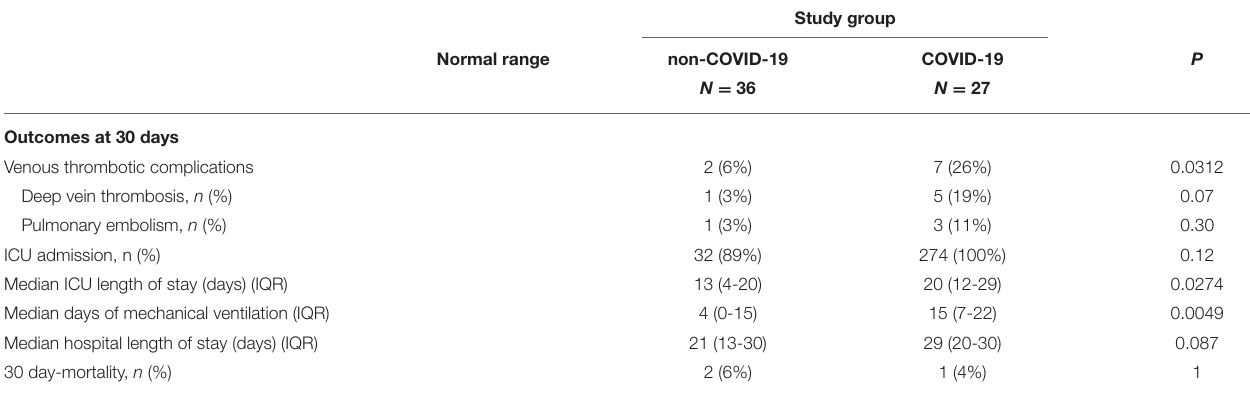
the 30 correlated original variables ( Supplementary Table 3 , Supplementary Figure 1 ). Two of the three factors in the final pattern were associated with outcomes. Factor 1 associated (1) baseline severity and extra-respiratory organ dysfunction (SOFA and PSI scores, lactate, creatinine and NT-ProBNP levels) and (2) “classical” markers of coagulation and endothelium activation (i.e. D-dimer, vWF-A2, sTM, sICAM1, TREM1, TFPI, uPA, VEGF). Factor 3 associated: (1) outcomes (duration of MV, ICU and hospital length of stay) and (2) sVCAM1 ( Supplementary Table 3 ). The projection of patient data onto the directions defined by Factors 1 and 3 showed a clear separation between COVID-19 and non-COVID-19 patients. By plotting patients according to different origins of pneumonia, we observed that most of the non-COVID-19 patients with proven bacterial (or mixed) origin had high Factor 1 values, while COVID-19 patients had high Factor 3 and low Factor 1 values ( Figure 2 ). Factor 2 associated: (1) white blood cell and platelets levels and (2) markers of platelet activation and growth factors (ie. CXCL4, sP-selectin, PDGF-AA, PDGF-AB/BB) ( Table 2 ). Planes defined by factor 2 did not enable any discrimination between patients according to COVID-19 status.